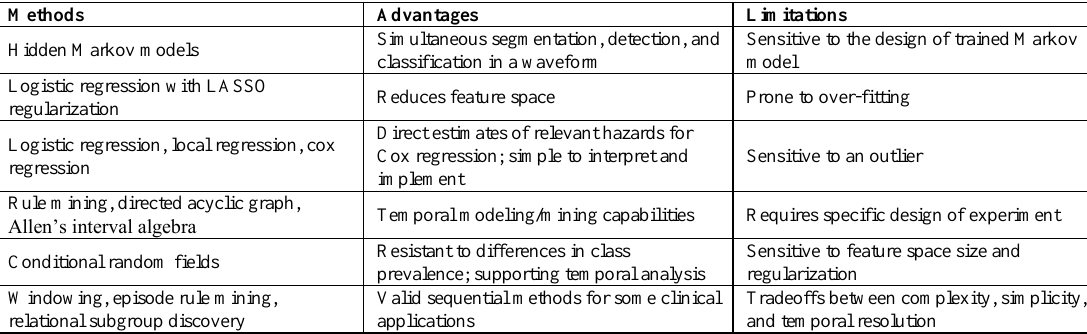
Table 7. Some methods for EHR data